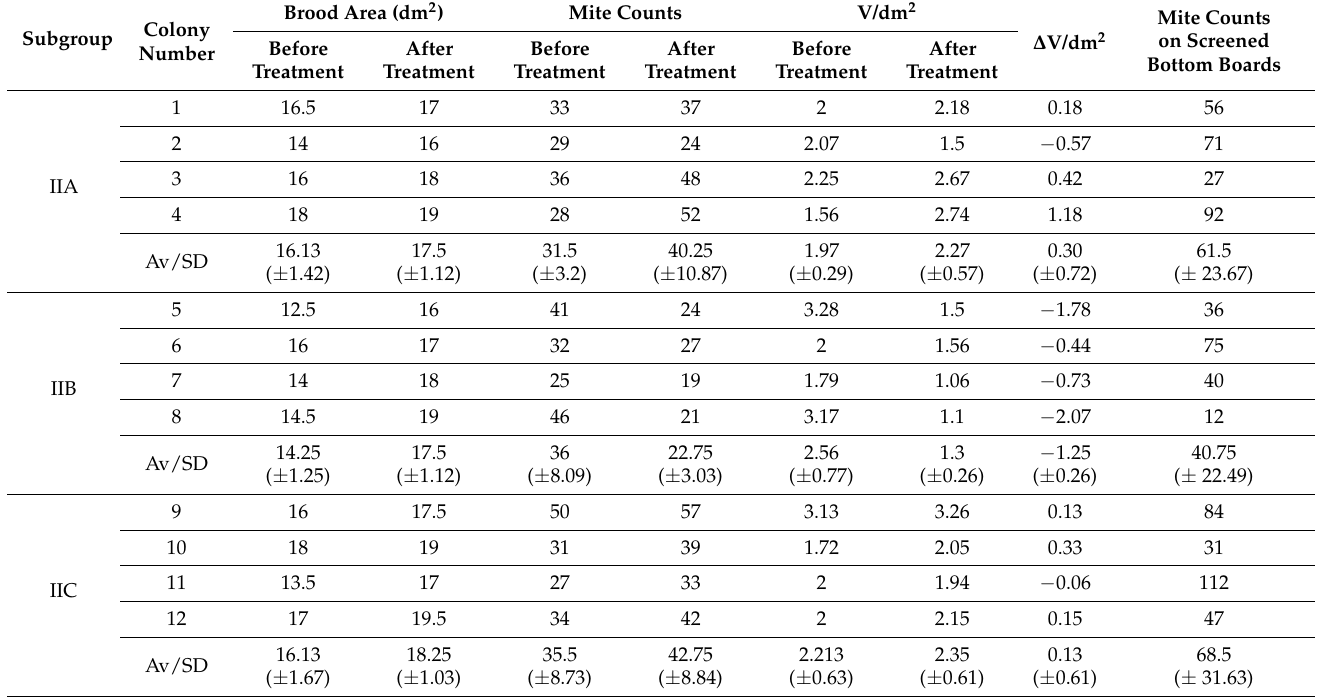
Table 3. Brood area (dm 2 ) and mite counts in group